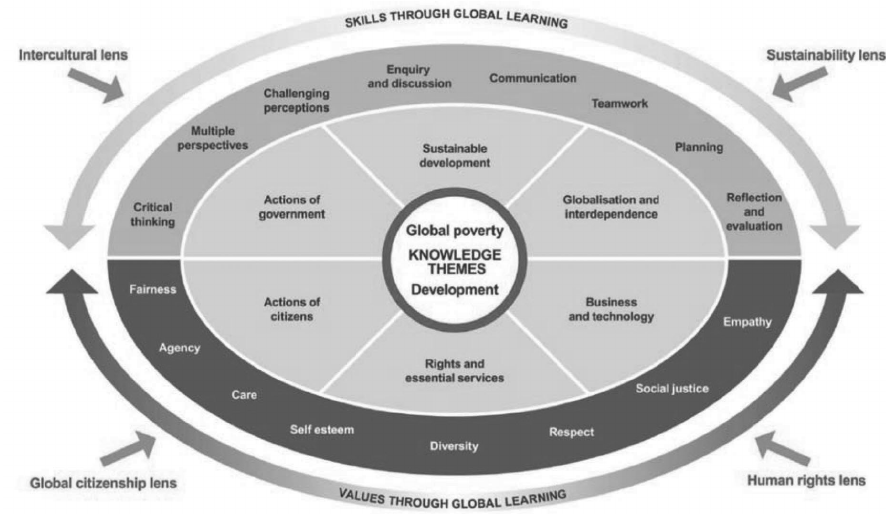
Figure 1: The GLP’s knowledge themes, skills, values, and lenses (GLP,